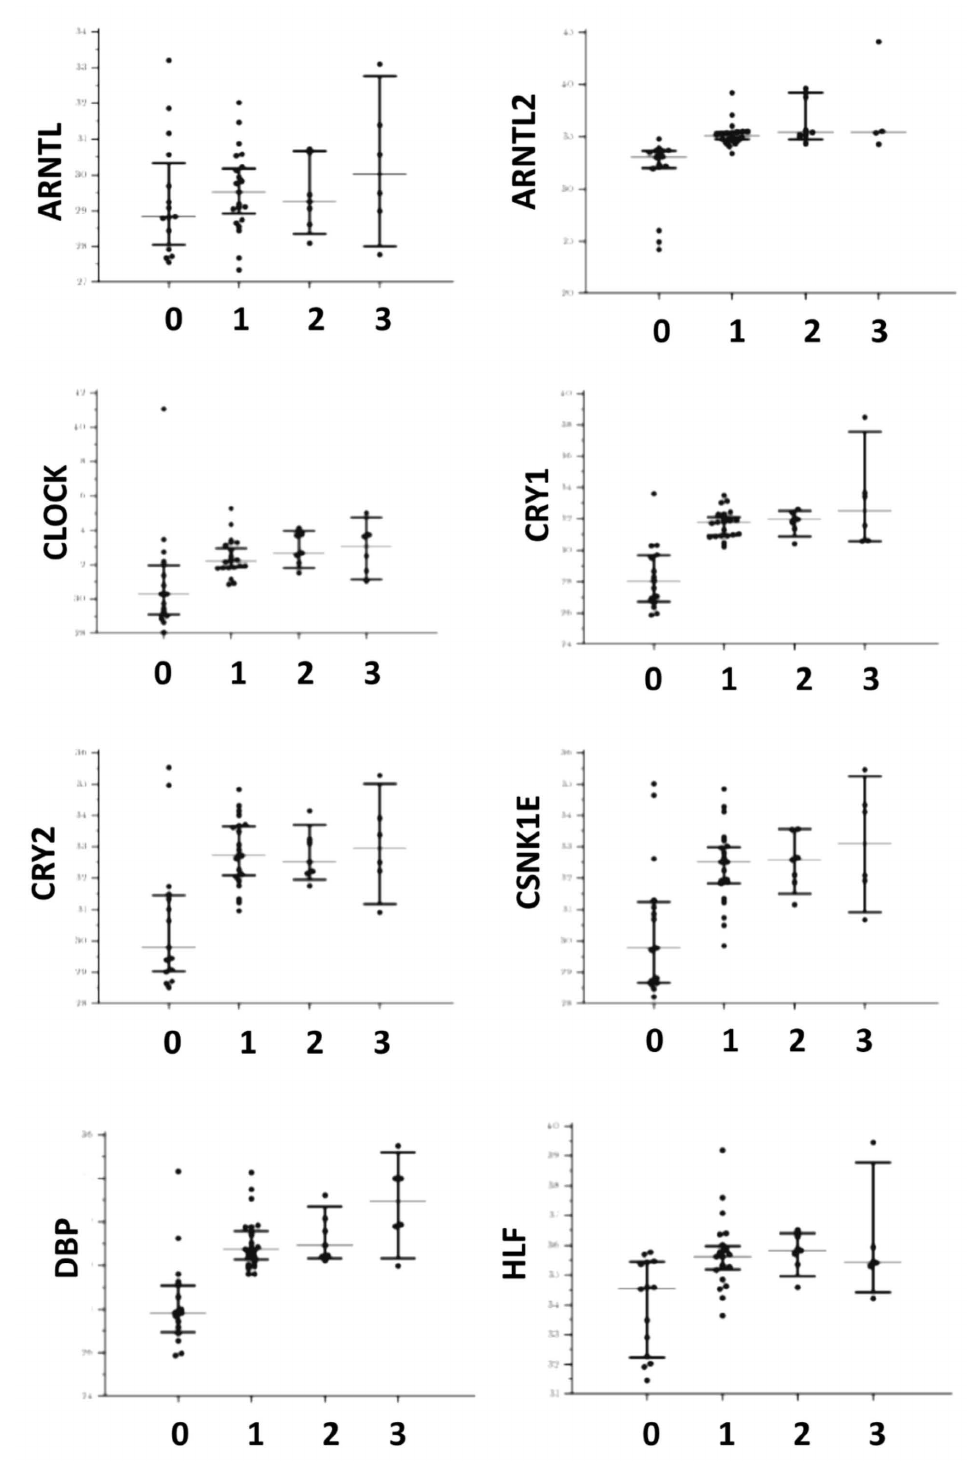
Figure 1. Distributions of gene expression in both controls and affected patients for ARNTL, ARNTL2, CLOCK, CRY1, CRY2, CSNK1E, DBP, and HLF. The central line corresponds to the median, upper, and lower bars to the IQR. For the X axis label, 0 corresponds to controls, 1 to AIP, 2 to HCP, and 3 to CEP and